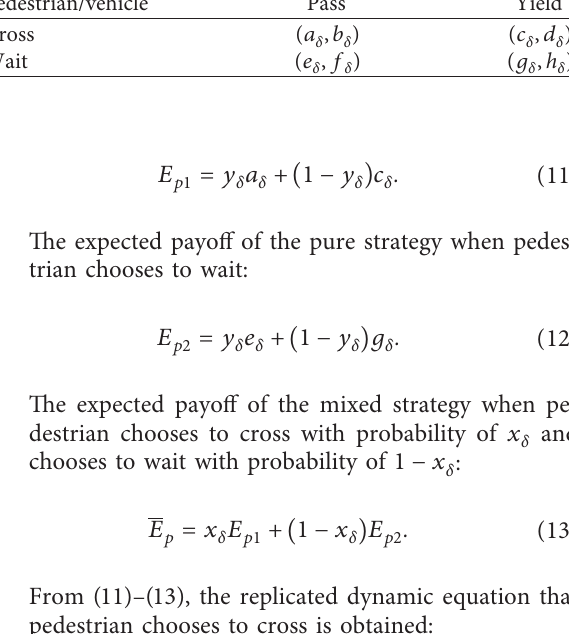
Table 2: Four situations of pedestrian-vehicle interaction and their corresponding probabilities.